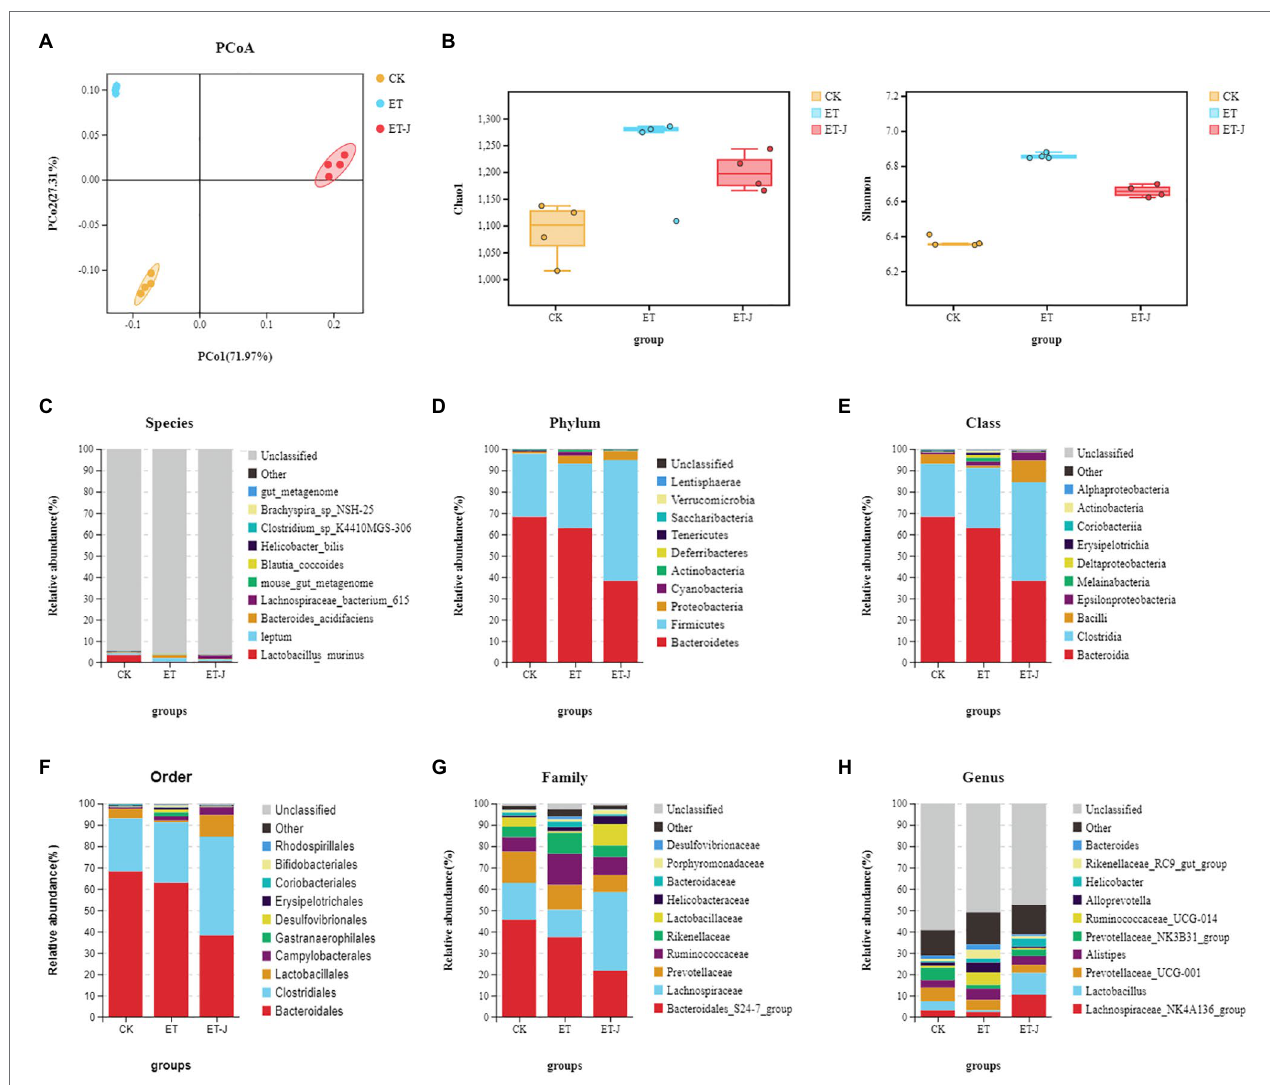
FIGURE 5 | The fermentation broth modulated the composition of the gut microbiota. (A) PCoA analysis among three groups based on weighted UniFrac distances. Each plot represents one sample. (B) The α -diversity of the intestinal flora indicated by the Shannon index and the Chao index ( n = 14). (C) Species-; (D) Phylum-; (E) Class-; (F) Order-; (G) Family-; and (H) Genus-level taxonomic distributions of microbial communities in cecal contents determined by 16S DNA